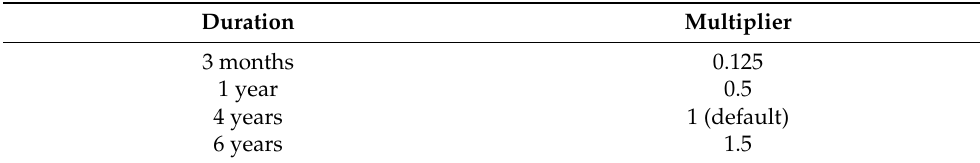
Table 13. Cost factor—sensitive information keeping F D